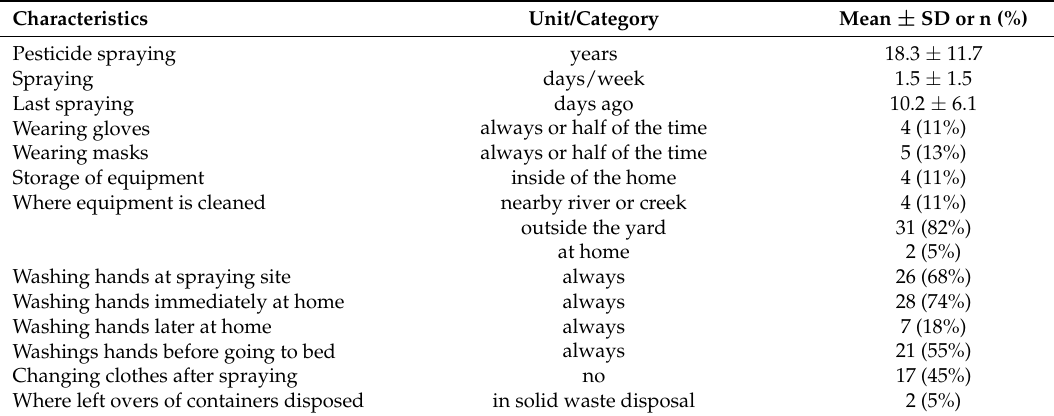
Table 2. Characteristics of pesticide use in pesticide exposed